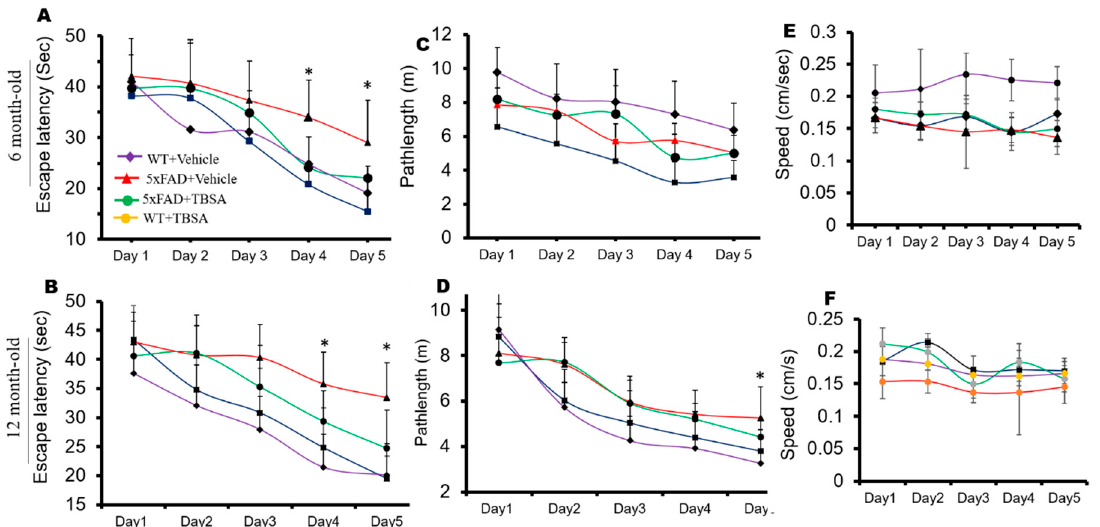
Figure 9. Treatments of trans-beta-styryl-boronic acid (TBSA) prevented spatial memory deficits in the acquisition trials of the Morris-water-maze task. After 2 months of treatment with TBSA (0.5 mg / kg) or vehicle the six- and twelve-month-old 5xFAD and age-matched control animals were tested on the Morris water maze (MWM) task for 5 days. The escape latency ( A , B ) was significantly longer for 6- ( A ) and 12-month-old ( B ) groups of 5xFAD mice in comparison to WT + TBSA and WT + vehicle-treated mice, with TBSA treatments preventing this deficit. The only between-group di ff erence observed in length of swim path to find the hidden platform ( C , D ) was between the 6-month-old vehicle-treated 5xFAD mice and WT controls on day 5, which was prevented by TBSA treatments ( D ). No significant di ff erences in swim speed were observed between any groups for either the 6- or 12-month-old mice ( E , F ). Values are expressed as means ± SEM. * p < 0.5 in comparison to WT + Vehicle, WT + TBSA.